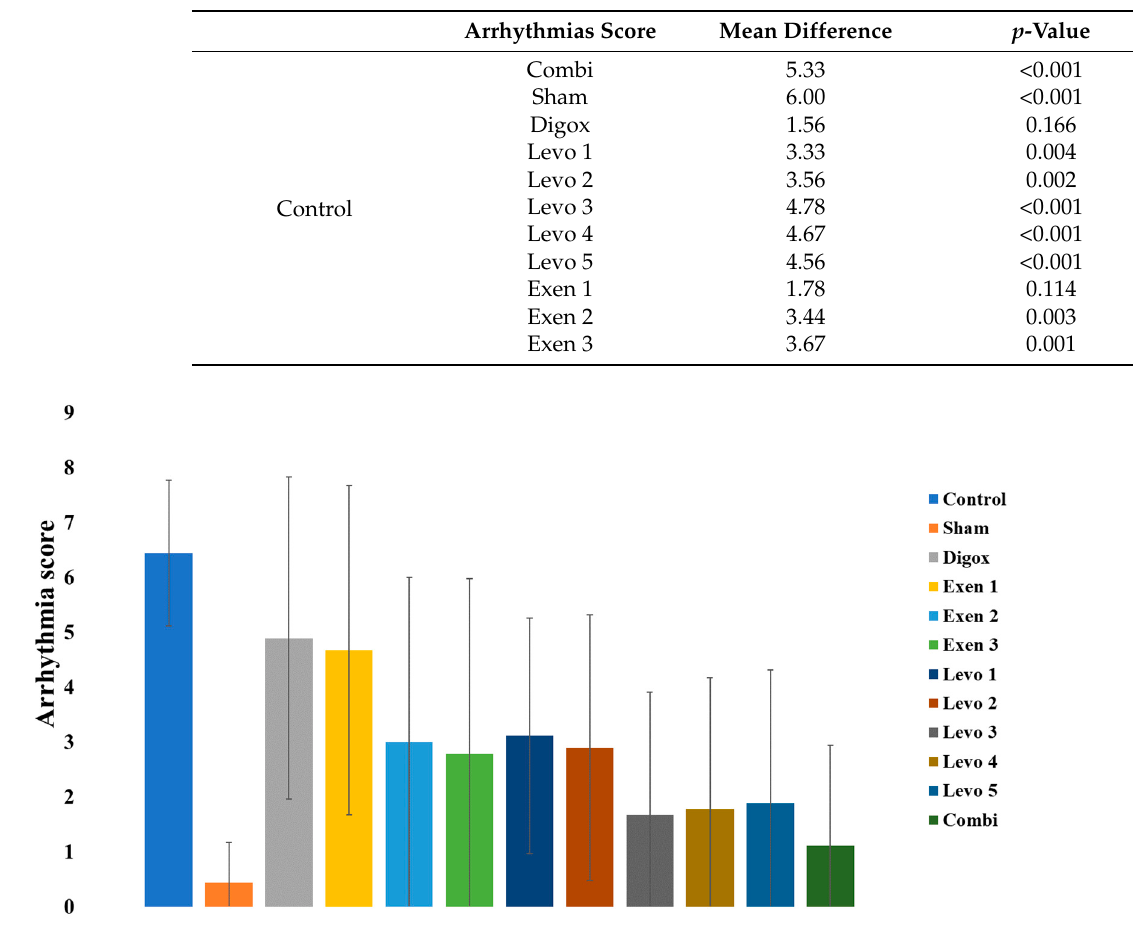
Table 10. Pairwise comparisons for arrhythmias score among groups.